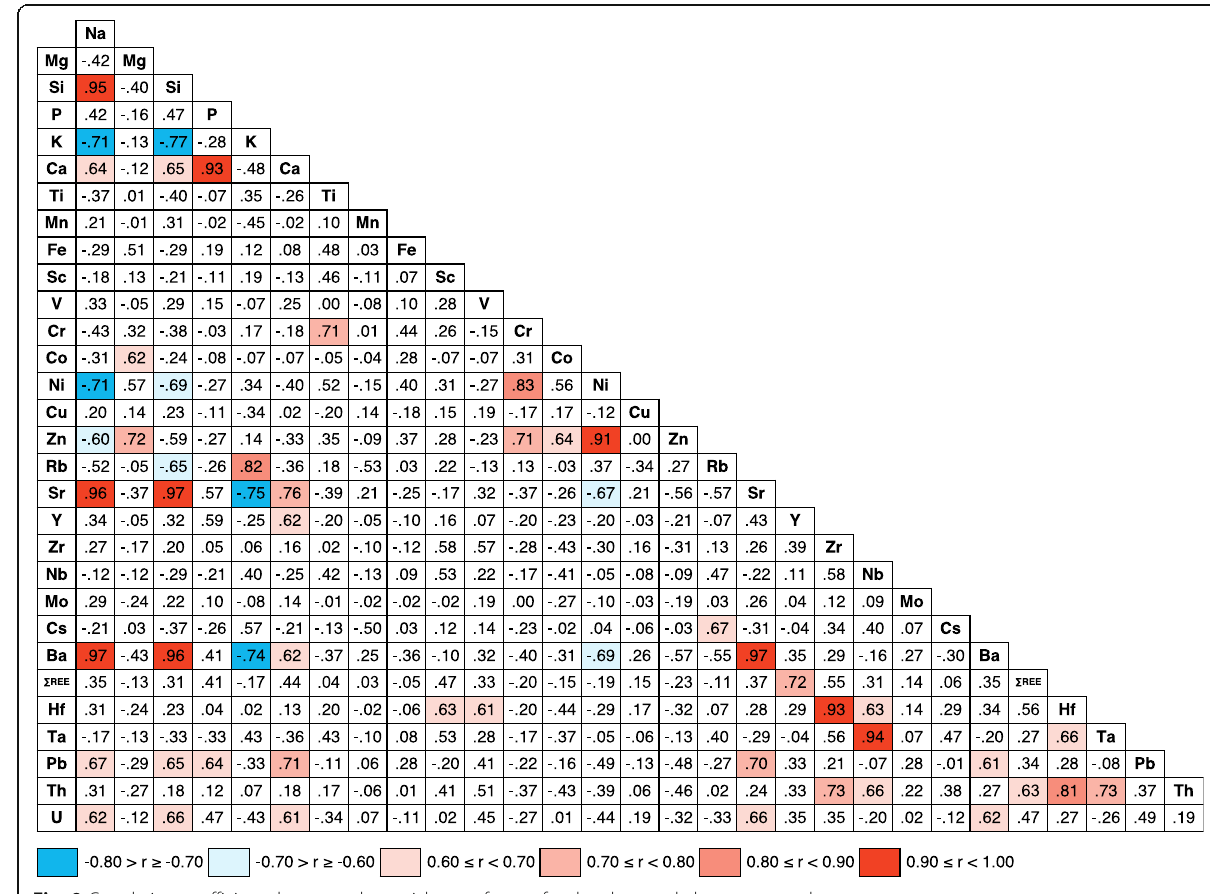
Fig. 9 Correlation coefficients between the enrichment factors for the chert and claystone